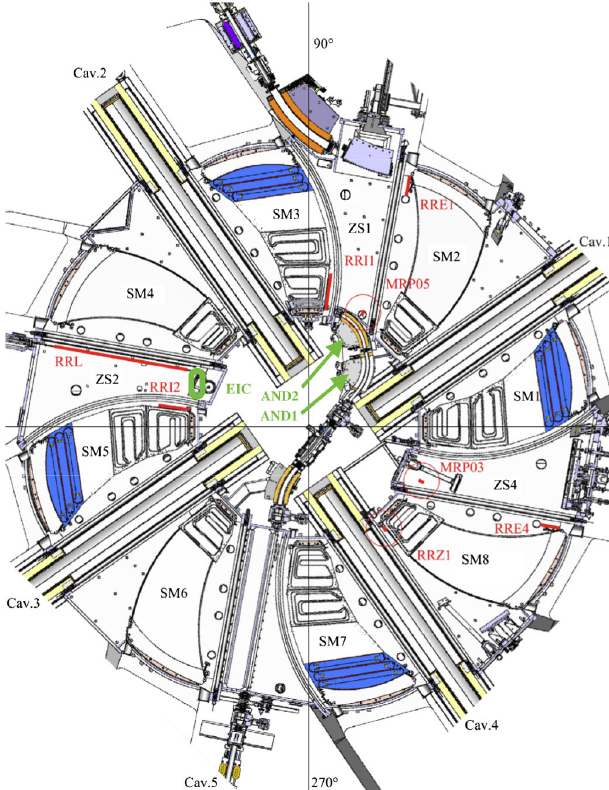
FIG. 1. Plan of the PSI Ring cyclotron. Probes and monitors are marked in red [1]. Injection elements are marked in